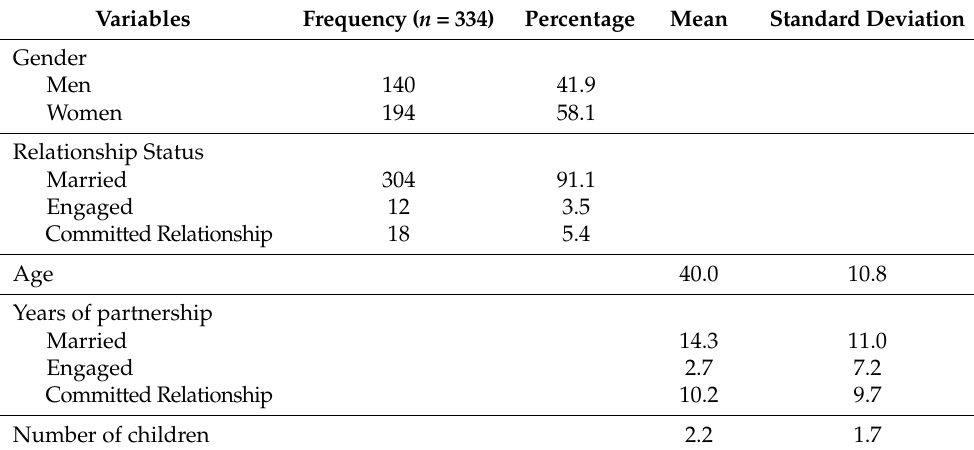
Table 1. Characteristics of